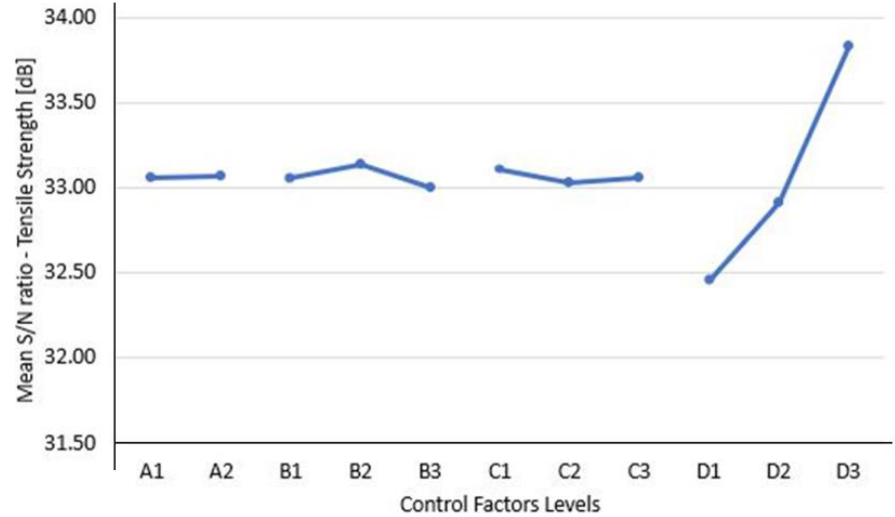
Figure 9. S/N ratio response graph for tensile strength.